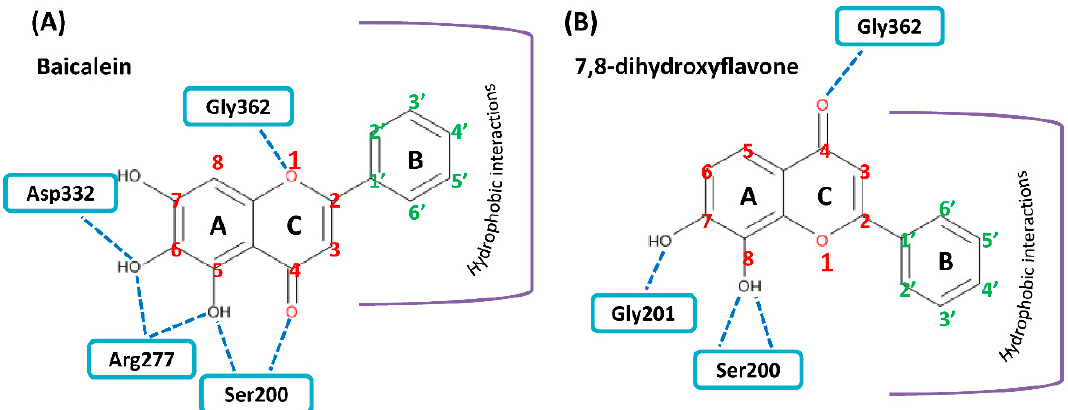
Figure 5. Schematic diagram for the chemical structure of baicalein and 7,8-DHF and the interacting residues of ODC. ( A ) Hydrogen bonding of the hydroxyl moieties at C-5 and C-6 on the A ring and the oxygen atom on the C ring of baicalein with Ser200, Arg277, Asp332, and Gly362 in the dimer interface of ODC. ( B ) Hydrogen bonding of the hydroxyl moieties at C-7 and C-8 on the A ring and the oxygen atom at C-4 on the C ring of 7,8-DHF with Ser200, Gly201, and Gly362 in the dimer interface of